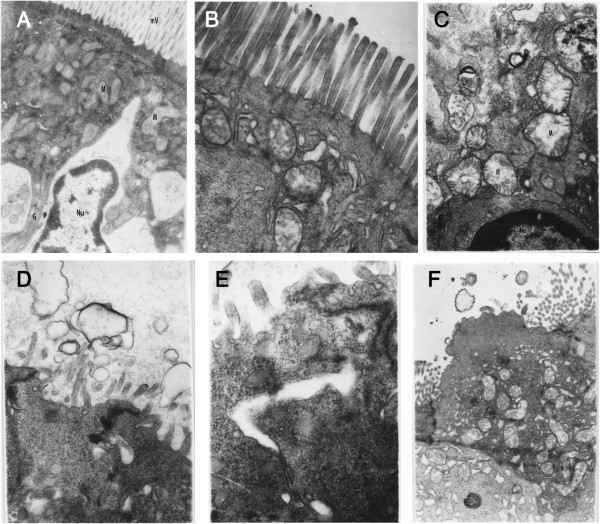
Pathological changes of intestinal mucosa observed by transmission electron microscopy. (A) Mitochondria (M) and microvilli (mV) in a normal jejunal mucosal epithelial cell (×10,000); (B) mildly swollen mitochondria but intact microvilli can be seen after an intra-abdominal pressure (IAP) of 15 mmHg for 4 hrs (×14,000); (C and D) severe mitochondrial swelling (M) and disruption of the cristae, and shortened, irregular and vacuolated microvilli can be seen after an IAP of 25 mmHg for 2 hrs (C: ×14,000, D: ×17,000); (E and F) discontinuous cell tight junctions, mitochondrial ballooning, degeneration and necrosis, and vacuolated and necrotic microvilli were seen that had begun to flake from the surface of membrane after an IAP of 25 mmHg for 6 hrs (E: ×20,000, F: ×7,000).